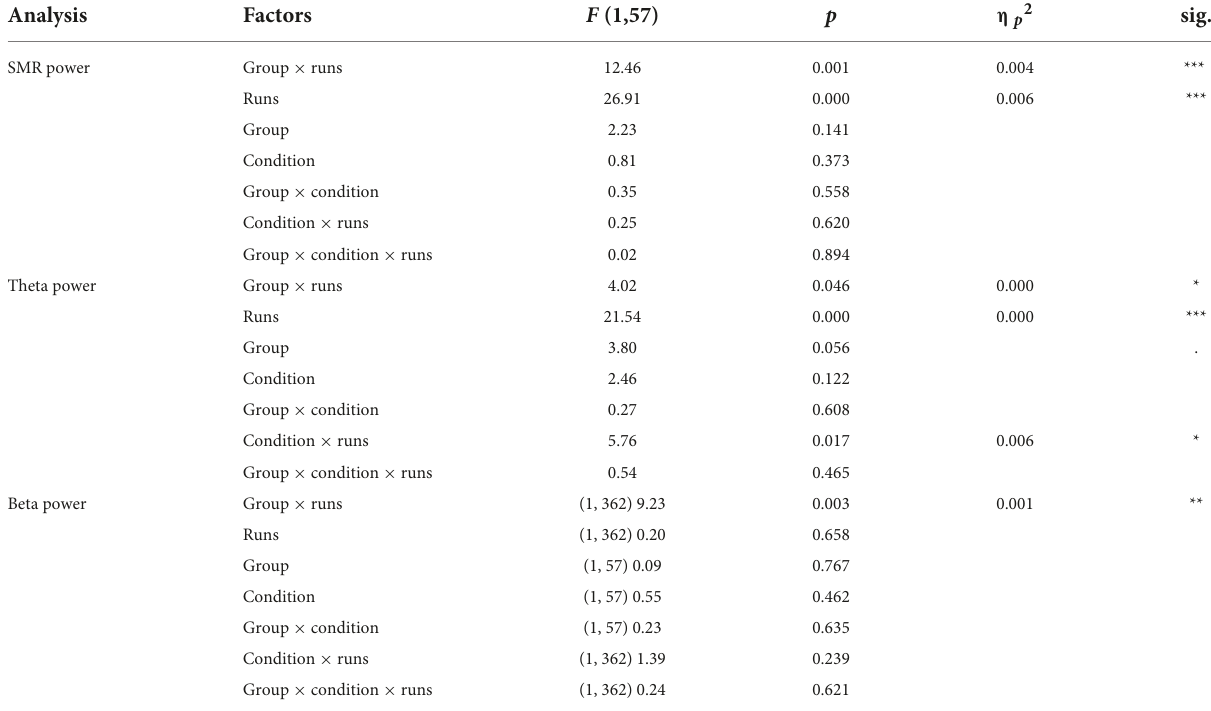
TABLE 2 F statistics of the linear mixed models for electroencephalography (EEG) power of SMR, Theta, and Beta.